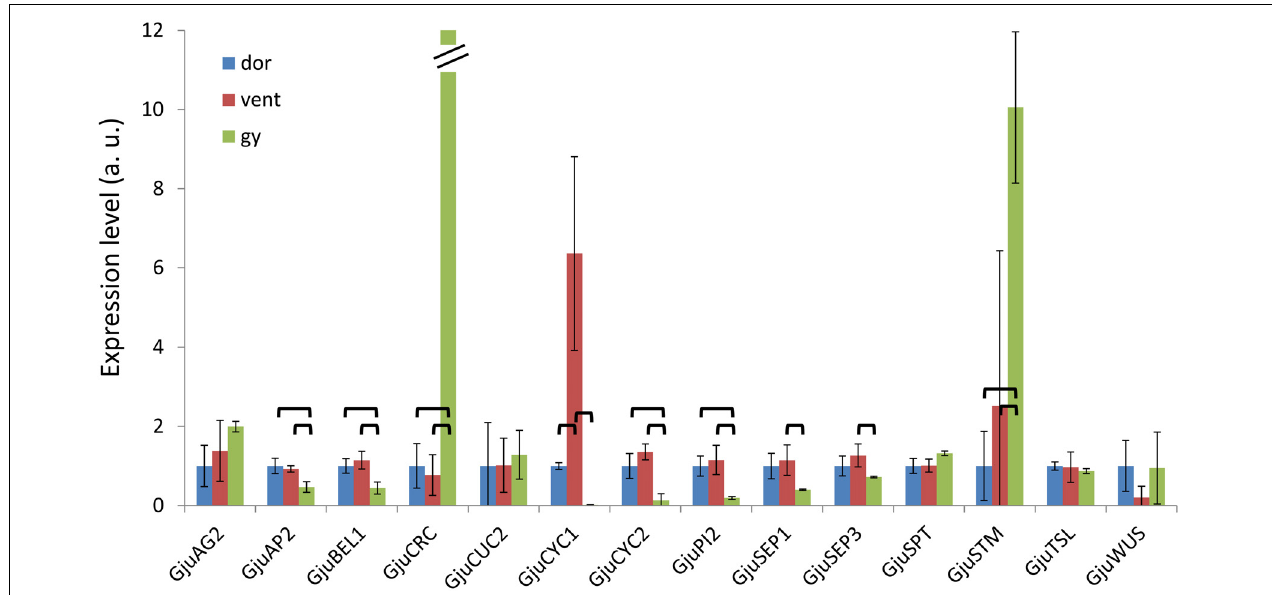
FIGURE 8 | Expression patterns of 14 floral genes assessed by qRT-PCR in floral dissections of Grevillea juniperina . Organs were dissected from 6–7 mm buds; dor, dorsal tepals and adnate stamens; vent, ventral tepals and adnate stamens; gy, gynoecium. For a better display, the normalized expression levels of each gene in this figure are shown relative to the dor sample. In this figure, the expression level of GjuCRC in the gynoecium is 844. The error bars are calculated from three biological replicates. The statistically significant pairwise comparisons are indicated with